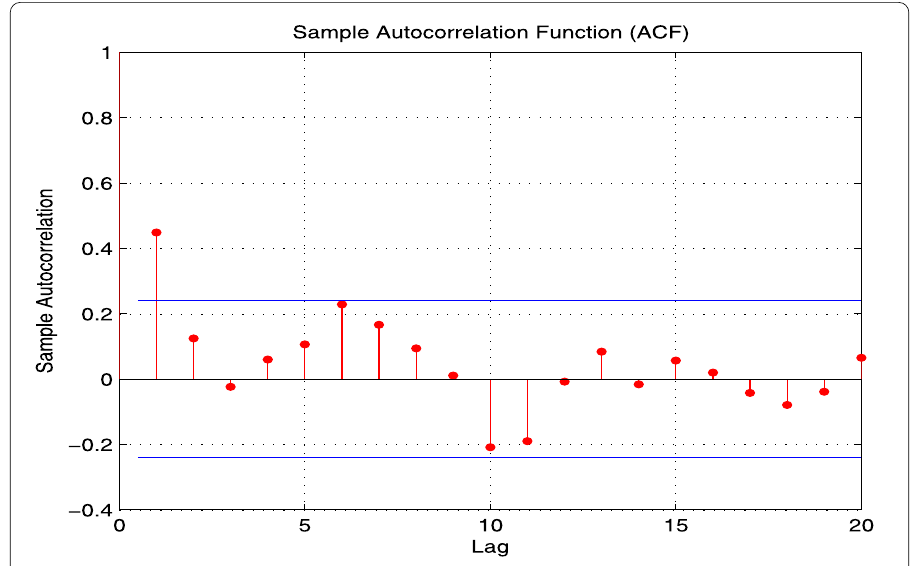
Figure 2 Sample autocorrelation function plot of transformed data Y t